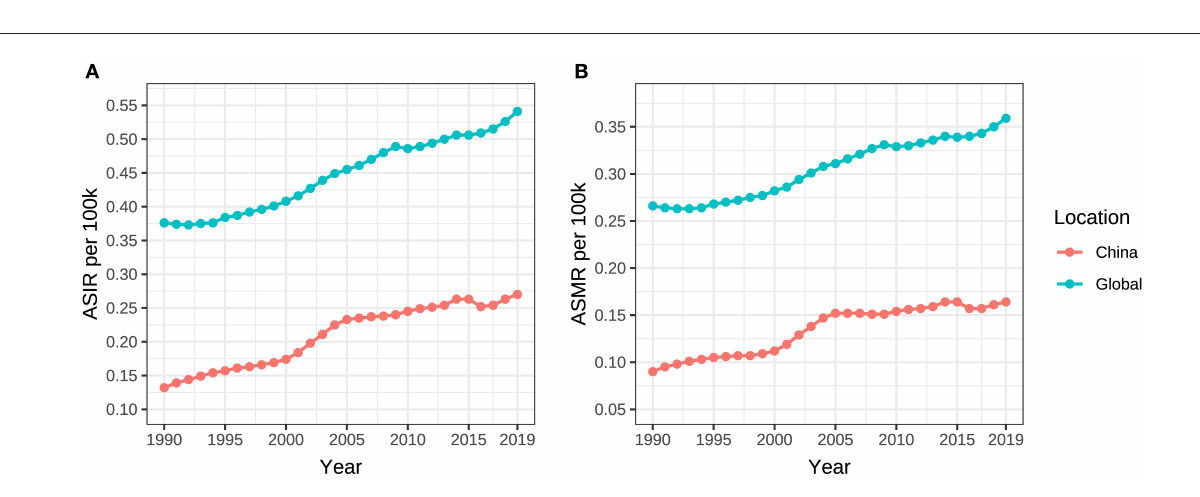
rate (ASDR), and average annual percent changes (AAPCs).